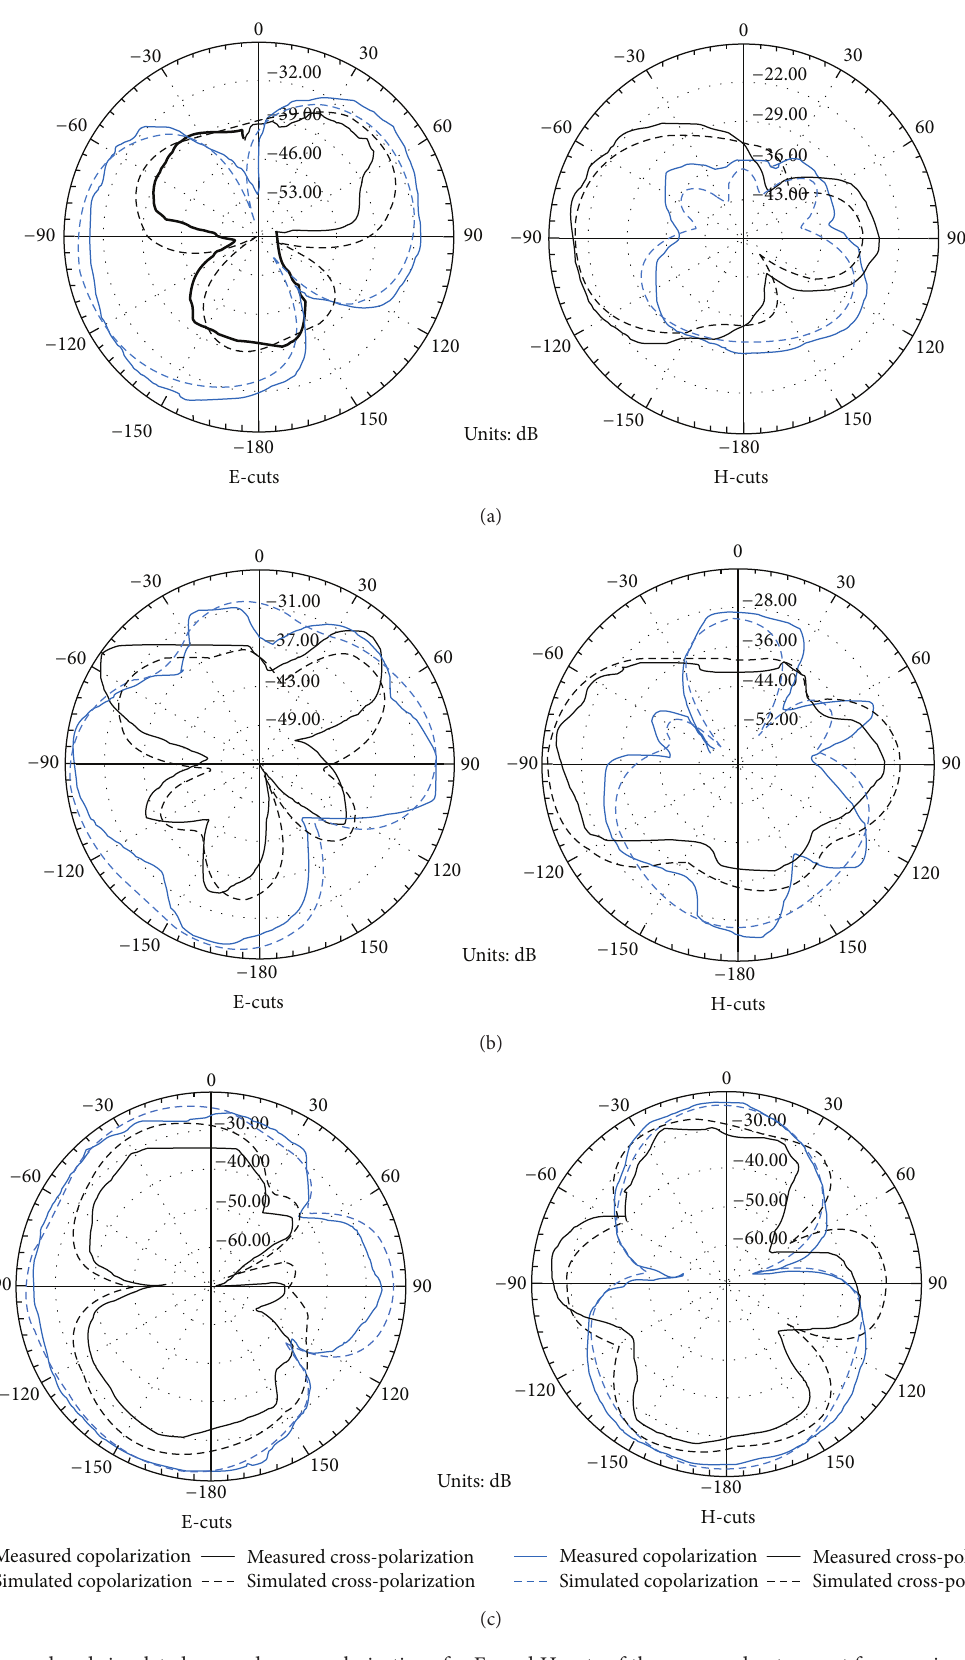
Figure 7: Measured and simulated co- and cross-polarizations for E- and H-cuts of the proposed antenna at frequencies of (a) 2.4, (b) 3.5, and (c) 5.5